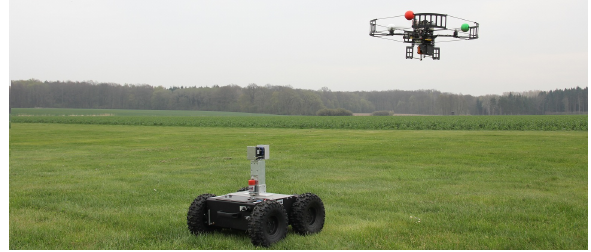
Figure 10: Field Test with UGV and UAV on model plane airfield Figure (11) shows the measurements from the laser scanner of the UGV in the laser scanner plane. The lift-off of the UAV can be seen clearly based on the green point cloud. These points cor- respond to the time of lift-off recorded on the UAV. The blue point clouds show the measurements during each turn of the UAV around the UGV. Finally the red point cloud corresponds to the time of the landing of the UAV at the end of five circles and 50s of flight time.